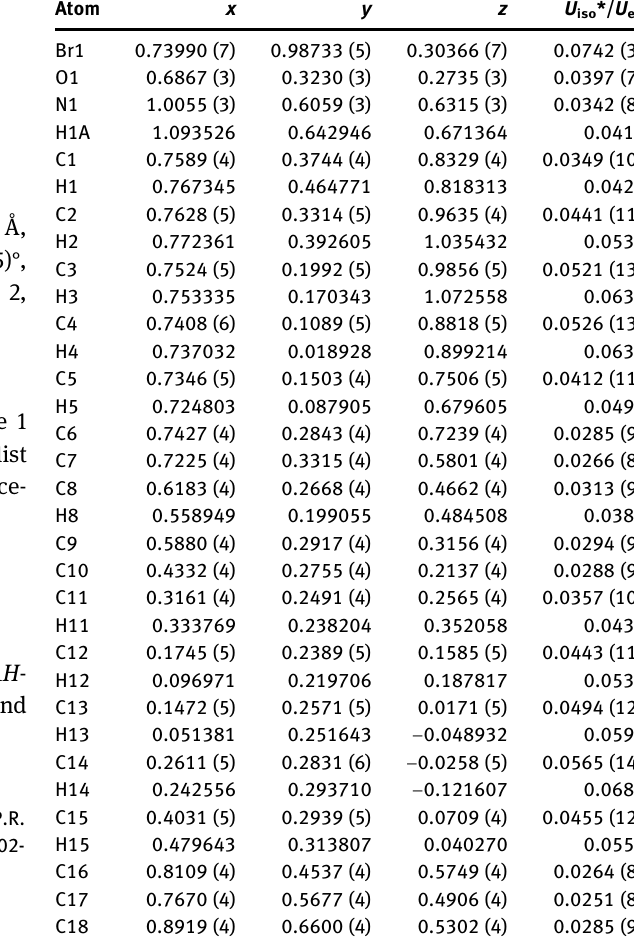
Table  : Fractional atomic coordinates and isotropic or equivalent isotropic displacement parameters (Å 